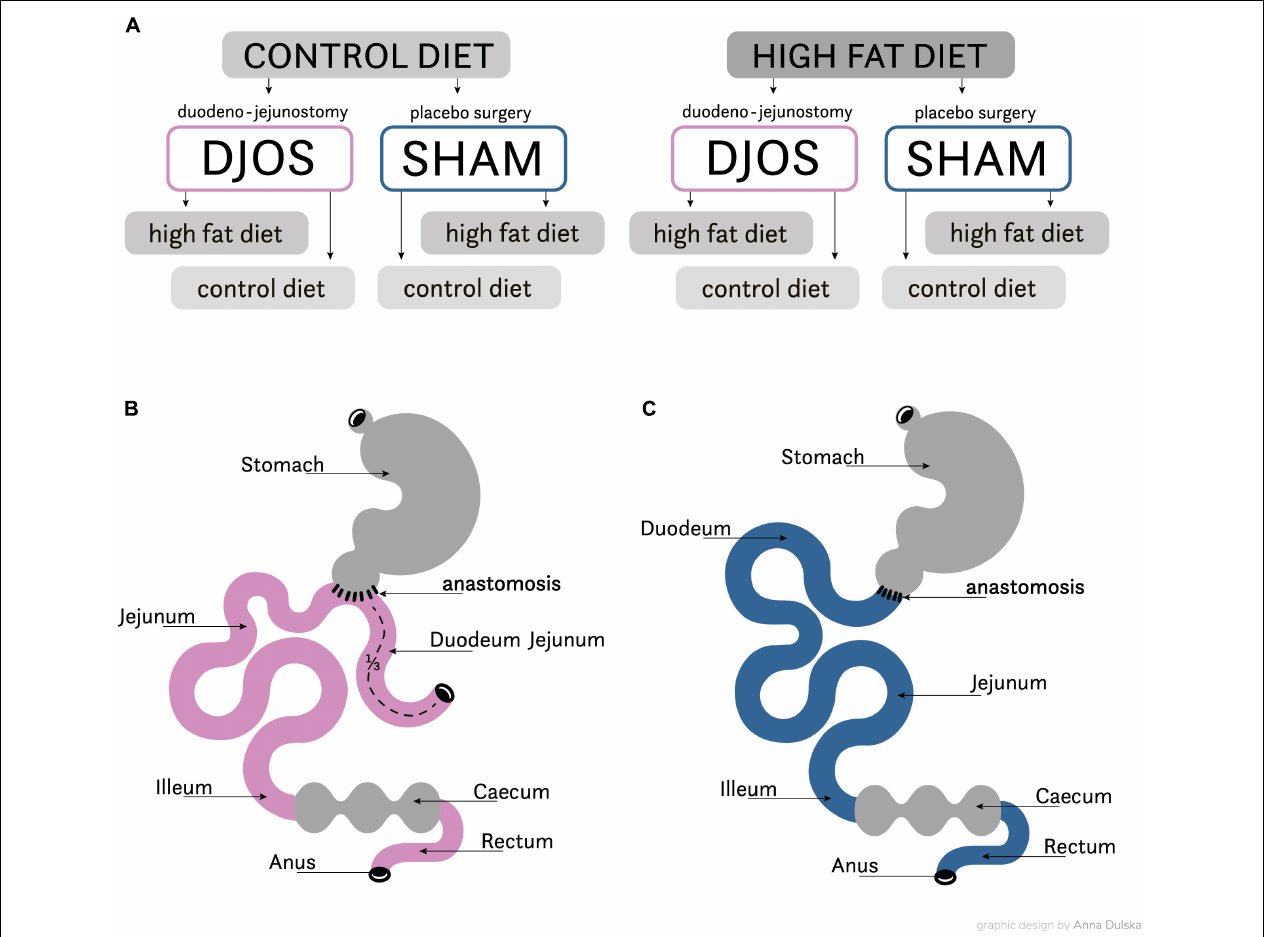
FIGURE 1 | (A) Scheme of experimental groups. (B) Schematic illustration of DJOS and (C) SHAM surgery, respectively.